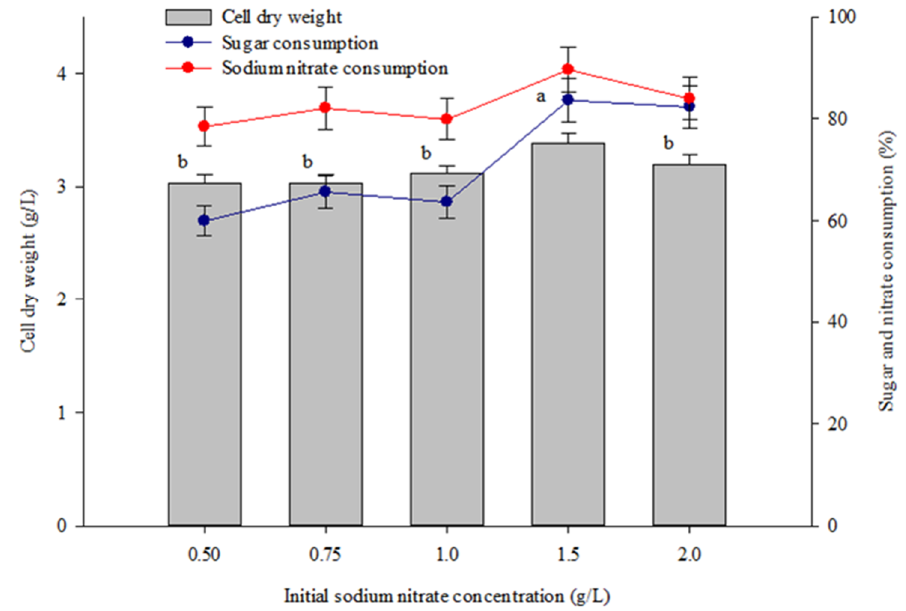
Figure 4. Effect of initial sodium nitrate concentration on biomass production and percentage of sugar and nitrate consumption of Coelastrella sp. KKU - P1 cultivated in molasses-based medium. Different lowercase letters on the top of the bars indicate the significant effects of the initial sodium nitrate concentrations on biomass production ( p ≤ 0.05, ANOVA with Duncan’s multiple range test).